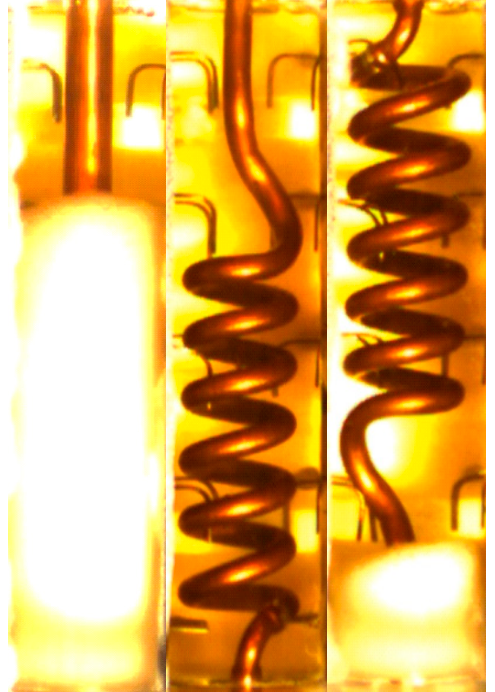
Figure 19. Melting front images for different geometry of storage units but for the same process time equal to 90 min and the same constant wall temperature condition ( Ts = 34 °C): at left for annular TES, at the middle for shell-and-coil TES with coil position at the bottom of the tank, at the right for shell-and-coil TES with coil position at upper of the tank.